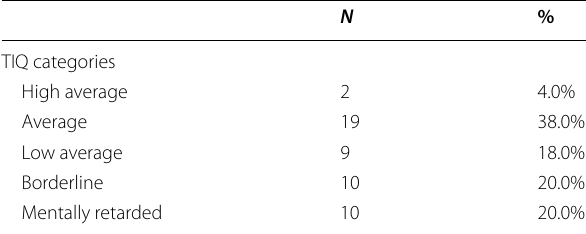
Table 3 Distribution of TIQ in the case group